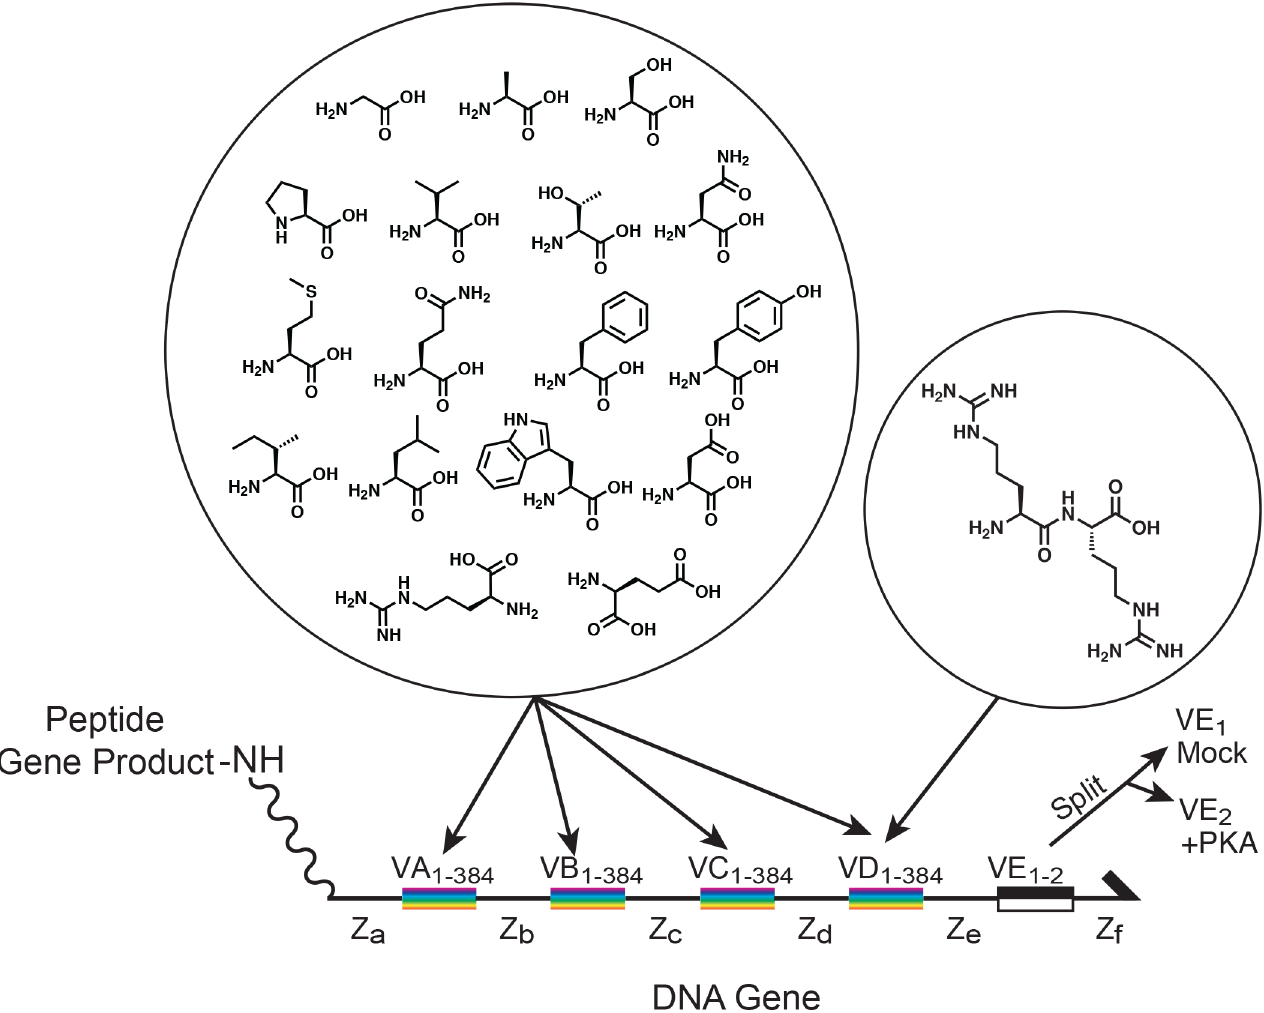
Fig 2. Gene structure. The genes that programed the synthesis of specific tetrapeptides were made up of four amino-acid coding regions (VA-VD, rainbow bars). 384 distinct DNA codon sequences were present at each coding region. Unlike the natural genetic code, each coding region used a set of codon sequences that were distinct from the codon sequences at the adjacent coding regions. Consequently, a total of 1536 different codon sequences were present in the library. The different codons at each coding position directed the addition of one amino acid from a set of seventeen different Fmoc-protected amino acids. An arginine dimer was included as an 18th amino acid in the fourth and final synthetic step, so some of the products were pentapeptides. An extra bar code (VE, black/white bar) specified whether the gene product would be subjected to a kinase substrate selection or to a control selection. Each peptide was coupled through a 5' polyethylene glycol linker to the gene that programmed its synthesis.